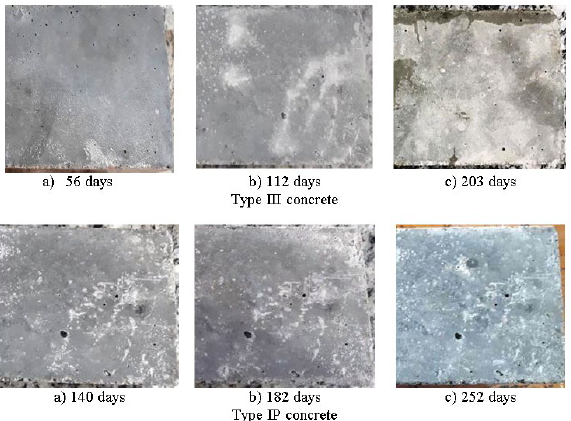
Figure 5. Visual inspection of concretes.